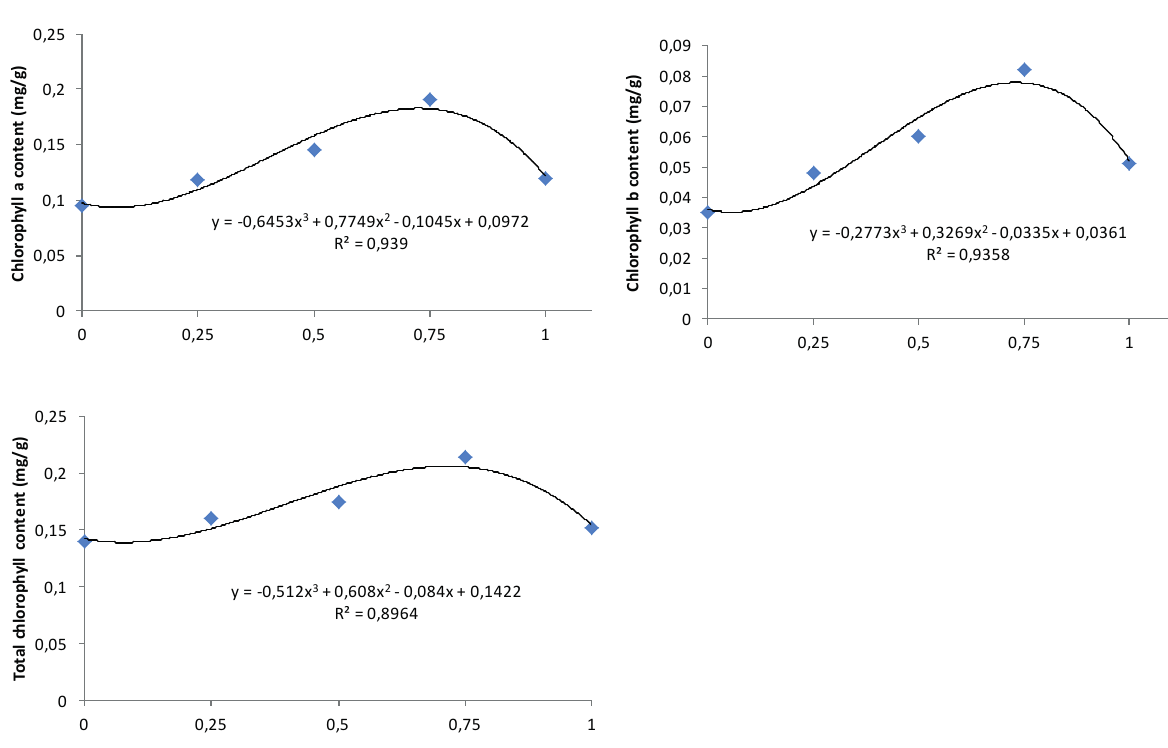
Figure 5 - The effect of different concentrations of nano-iron oxide on soybean seed chlorophyll